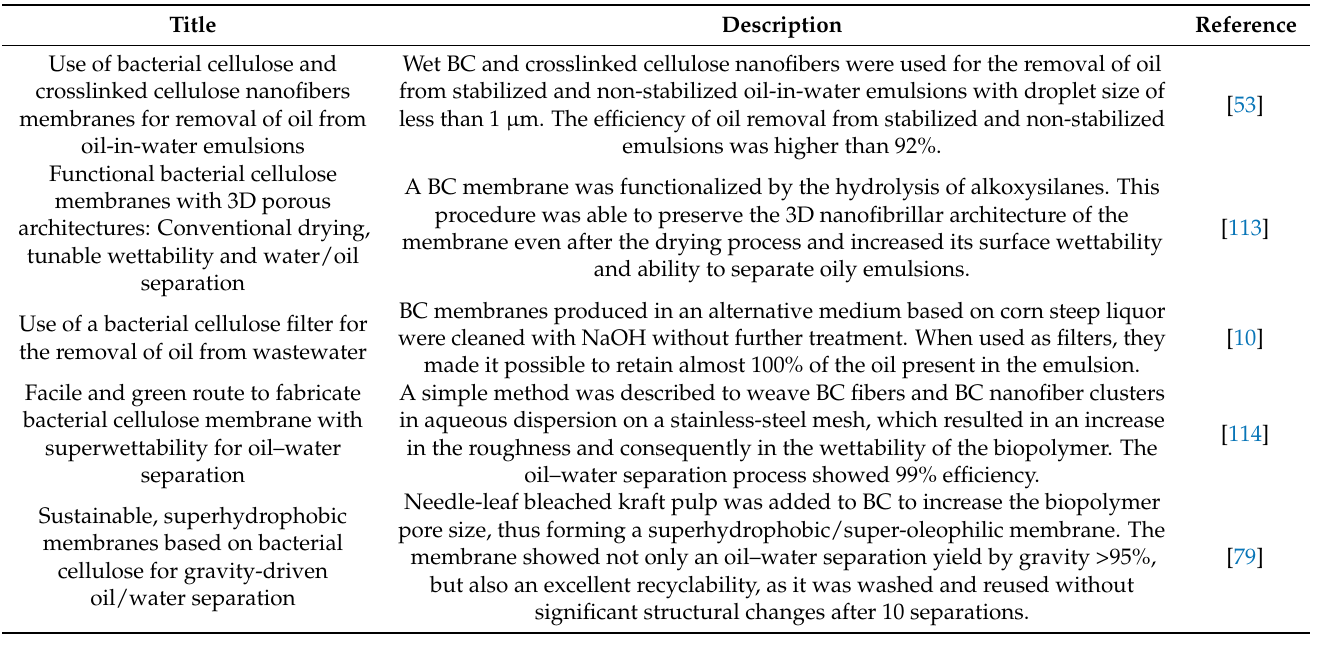
Table 4. Articles related to the use of bacterial cellulose (BC) membranes as porous bed for separation of water–oil